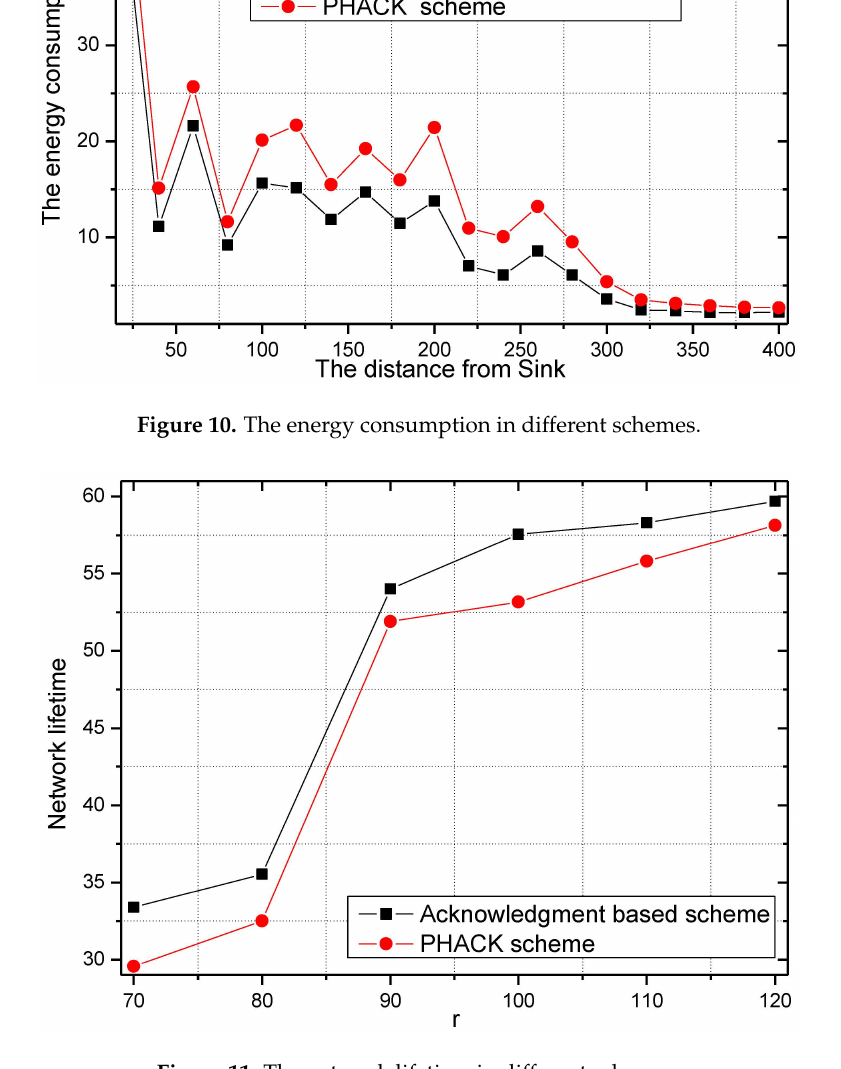
Figure 11. The network lifetime in different